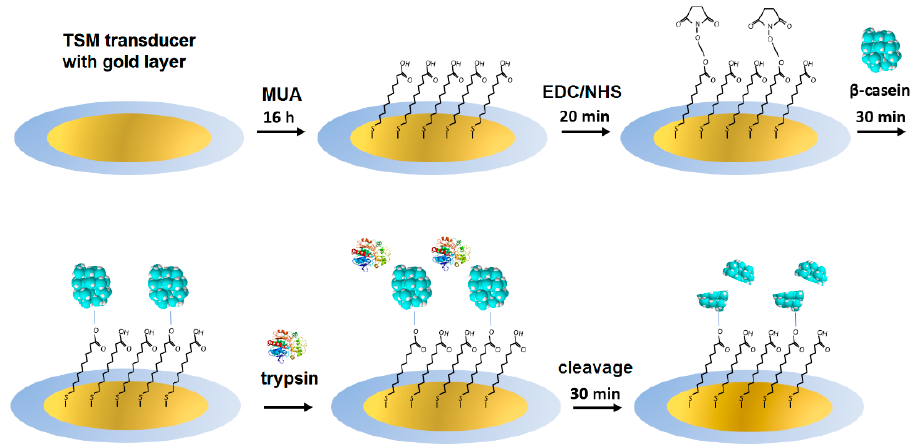
Figure 1. The scheme for modification of the gold layer on a TSM transducer and the cleavage of β -casein by